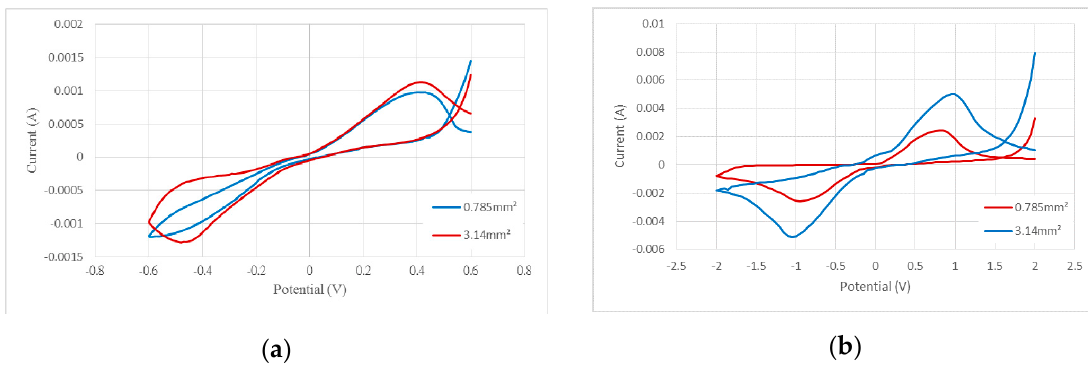
Figure 6. Cyclic voltammetry curves for different electrode surface areas with a voltage range of ( a ) ±0.6 V and ( b ) ±2 V.